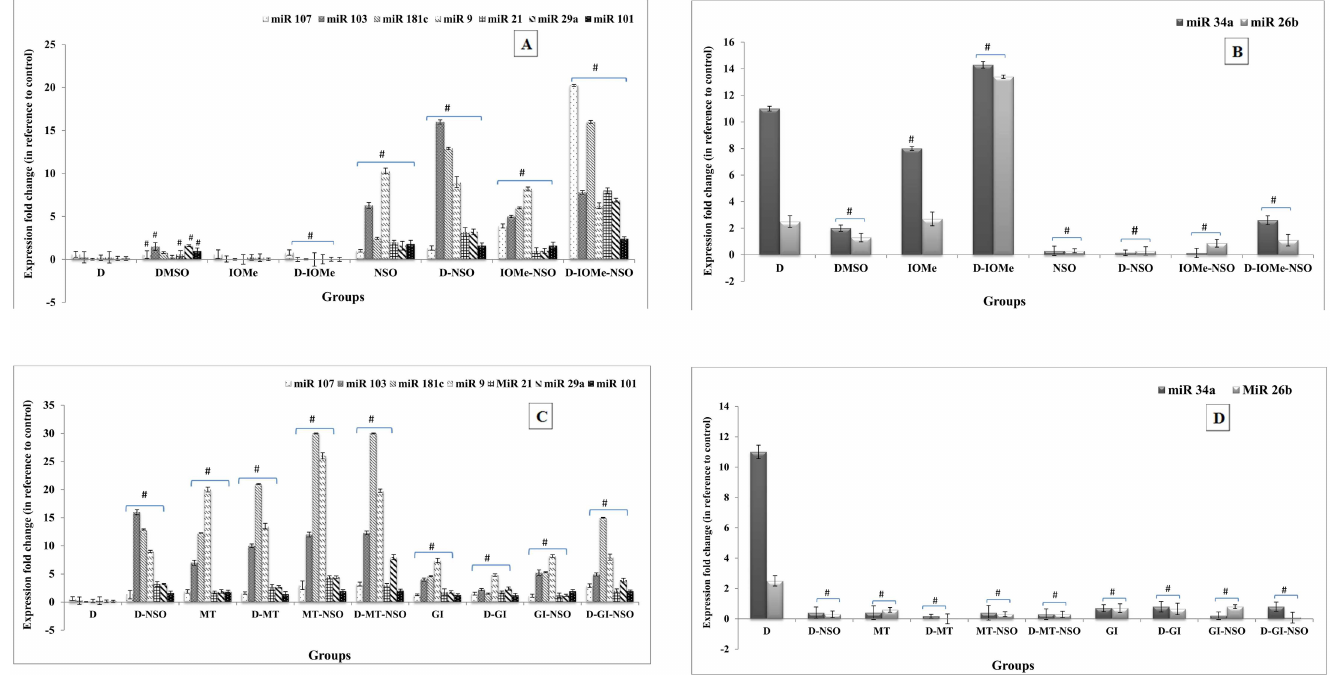
Fig 4. Quantitative RT-PCR analysesof brain AD-related miRNAs expressionprofile. Alterationsin the expressionlevels of AD-related miRNAs (107, 103, 9, 181c, 21, 101 and 29a) in the brain homogenate of experimental diabetic rats injected with IOMe and treated with NSO (A). Alterationsin the expressionlevel of miRNAs 34a and 26b in the brain of IOMe-injected diabetic rats and treated with NSO (B). Alterationsin the expressionlevels of AD- related miRNAs (107, 103, 9, 181c, 21, 101 and 29a) in the brain of diabetic rats after treatment with NSO, anti-diabeticdrugs and combination therapy (C). Alterationsin the expressionlevel of miRNAs 34a and 26b in the brain of experimental diabetic rats after treatment with NSO, anti-diabeticdrugs and combination therapy (D). Significance is shown as (#p < 0.05) comparedto diabetes-inducedrats.